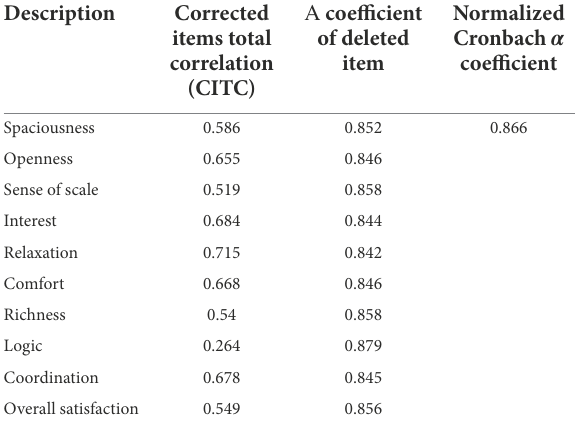
TABLE 3 Total factor reliability